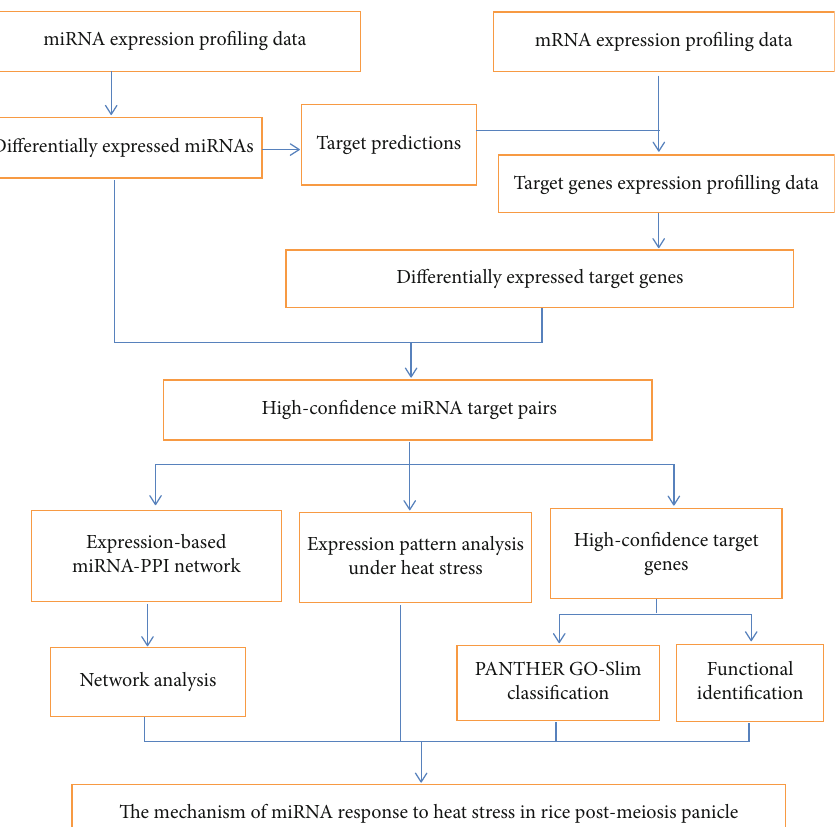
Figure 1: Flowchart of the general procedure of this